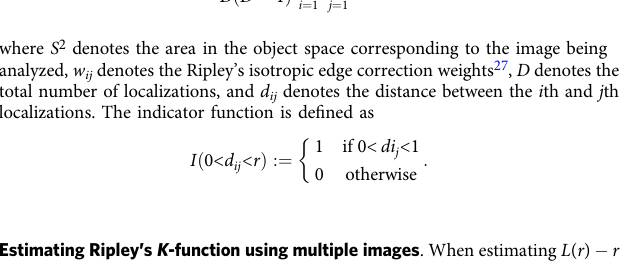
● Algorithm 1 (Wavelet): Detects molecules or clathrin-coated pits using wavelet- fi ltering 22 and estimates their locations by fi tting Airy pro fi les to the detected molecules or Gaussian pro fi les to the detected pits. Further details are provided below. ● Algorithm 2 Detects and localizes molecules using the default settings of the software package taken from ref. 23 . ● Algorithm 3 Detects and localizes molecules using the default settings of the software package taken from ref. 24 . ● Algorithm 4 (Global-Thresholding): Detects molecules or clathrin-coated pits by identifying pixels above a threshold value and estimates their locations by fi tting Airy pro fi les to the detected molecules or Gaussian pro fi les to the detected pits. Further details are provided below. ● Algorithm 5 Detects and localizes molecules using the default settings of the software package taken from ref. 25 . ● Algorithm 6 Detects and localizes molecules using the default settings of the multiemitter version of the software package taken from ref. 23